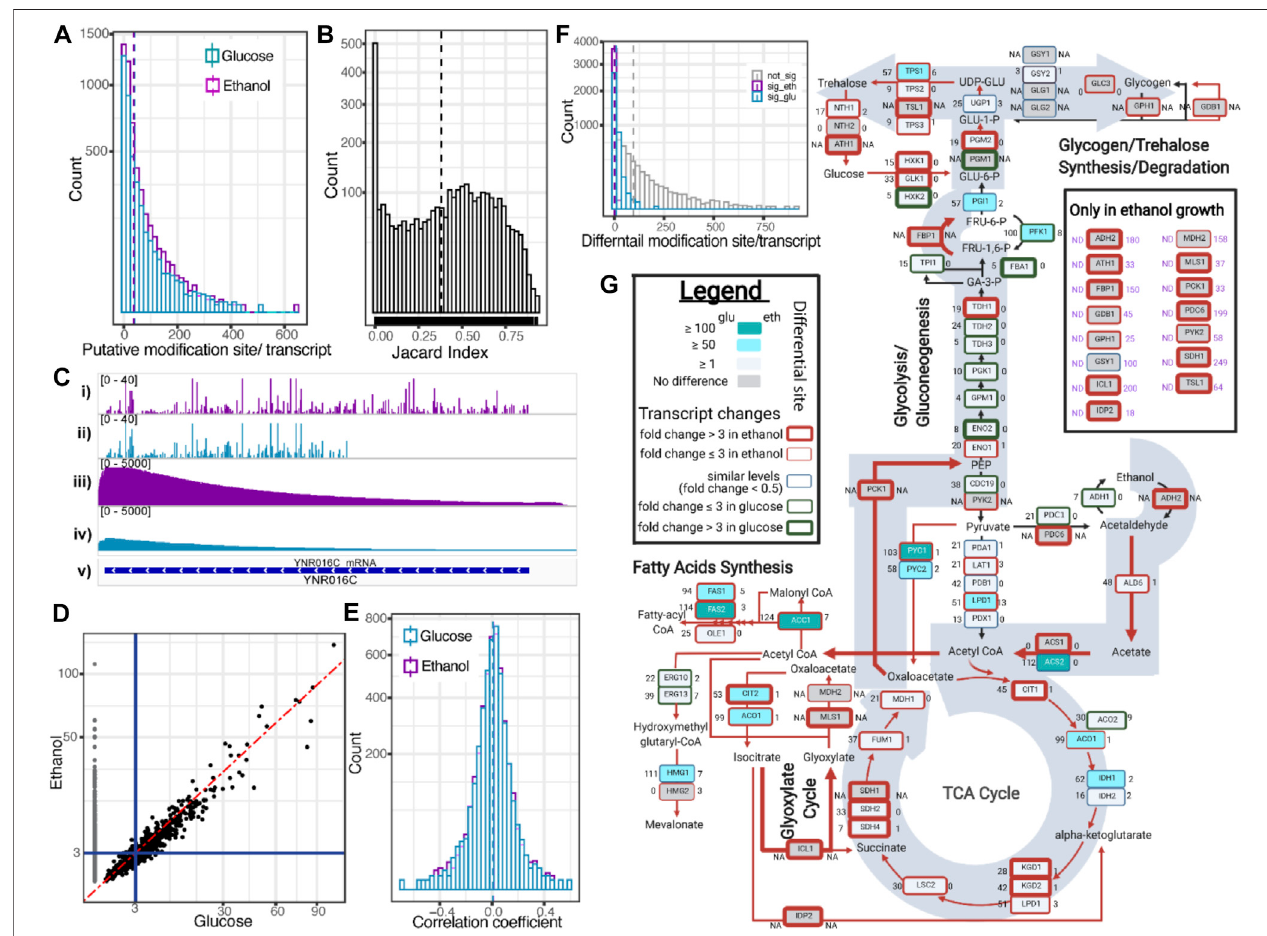
FIGURE4| Capturing mRNAmodi fi cationinferred fromdRNAsequences. (A) Histogram plotshowsputativemodi fi cation sitepertranscriptidenti fi edbyELIGOS. Dashed lines show the mean value. (B) Histogram plot shows Jaccard ’ s indexes representing degree of commonality of putative modi fi cation sites of individual transcripts between yeast grown in glucose and ethanol. Dashed line shows the mean value. (C) IGV snapshot of ACC1 contains the highest number of putative modi fi cation sites and shows the comparison of identi fi ed putative modi fi cation sites of yeast grown in ethanol (i) and glucose (ii) with sequencing depth coverage alongthe transcript length (ethanol (iii) and glucose (iv)). The ACC1 transcriptregion isshown in lane(v). (D) Scatter plot comparingodd ratios indicates the probability of RNA modi fi cations along the ACC1 transcript between yeast growth on glucose and ethanol. The black dots show the odd ratios that can be computed in both conditions. The gray dots show the odds ratios that can be computed only in ethanol growth. Red dashed line is a diagonal line. (E) Histogram plot showing Pearson ’ s correlation coef fi cient between odds ratios and the predicted SHAPE score. Dashed lines show the mean value. (F) Summary of differential modi fi cation sites per transcript between yeast growth on ethanol and glucose. The signi fi cant modi fi cation sites ofethanol and glucose growth are shown in magentaand cyan, respectively. The non-signi fi cant sites areshown ingray. (G) Summary ofdifferential RNA modi fi cation inthe central metabolic pathway that isknown tobe transcriptionally regulated between growth on glucose and ethanol. All y -axes of histogram plots are square-root scale. All magenta and cyan colors represent results of ethanol and glucose, respectively.